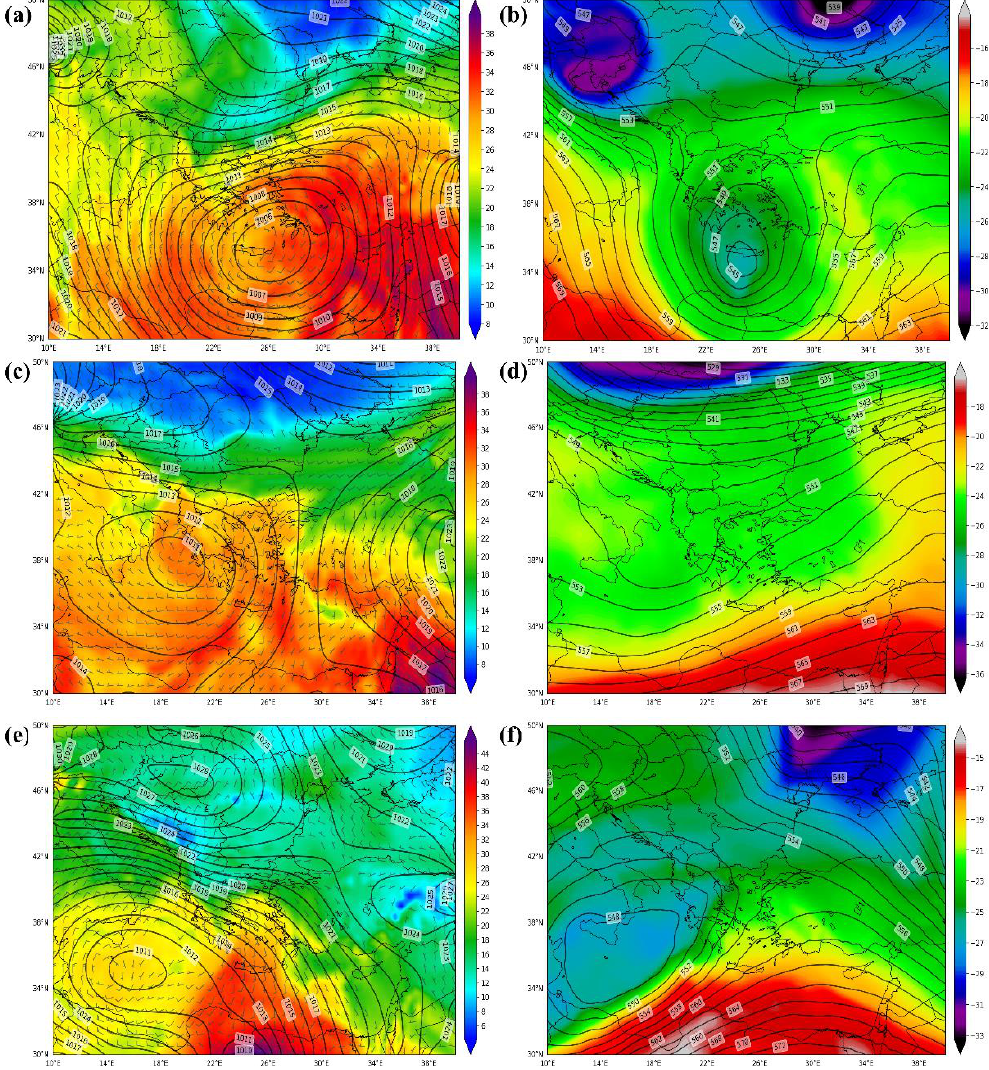
Figure 3. As in Figure 2 but for 11 December 2011, 0400 UTC ( a , b ), 2 January 2011, 1500 UTC ( c , d ), and 3 February 2011, 0600 UTC ( e , f ).